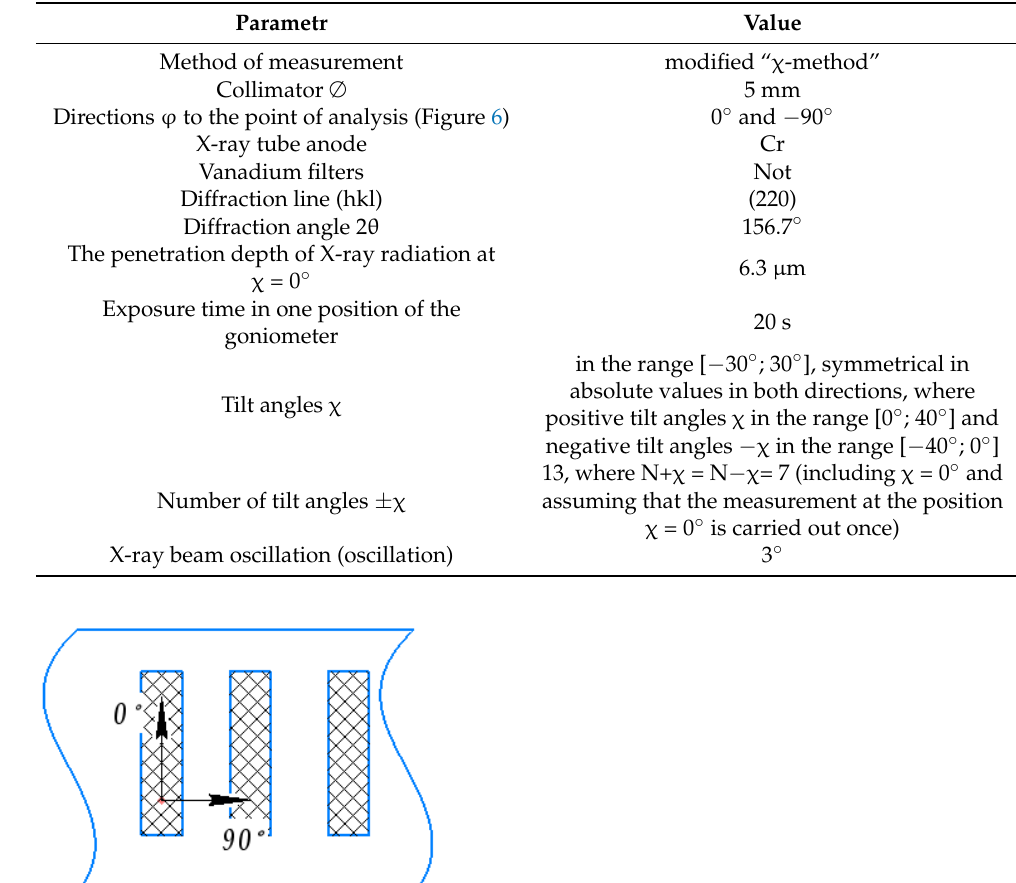
Table 4. OH measurement modes.